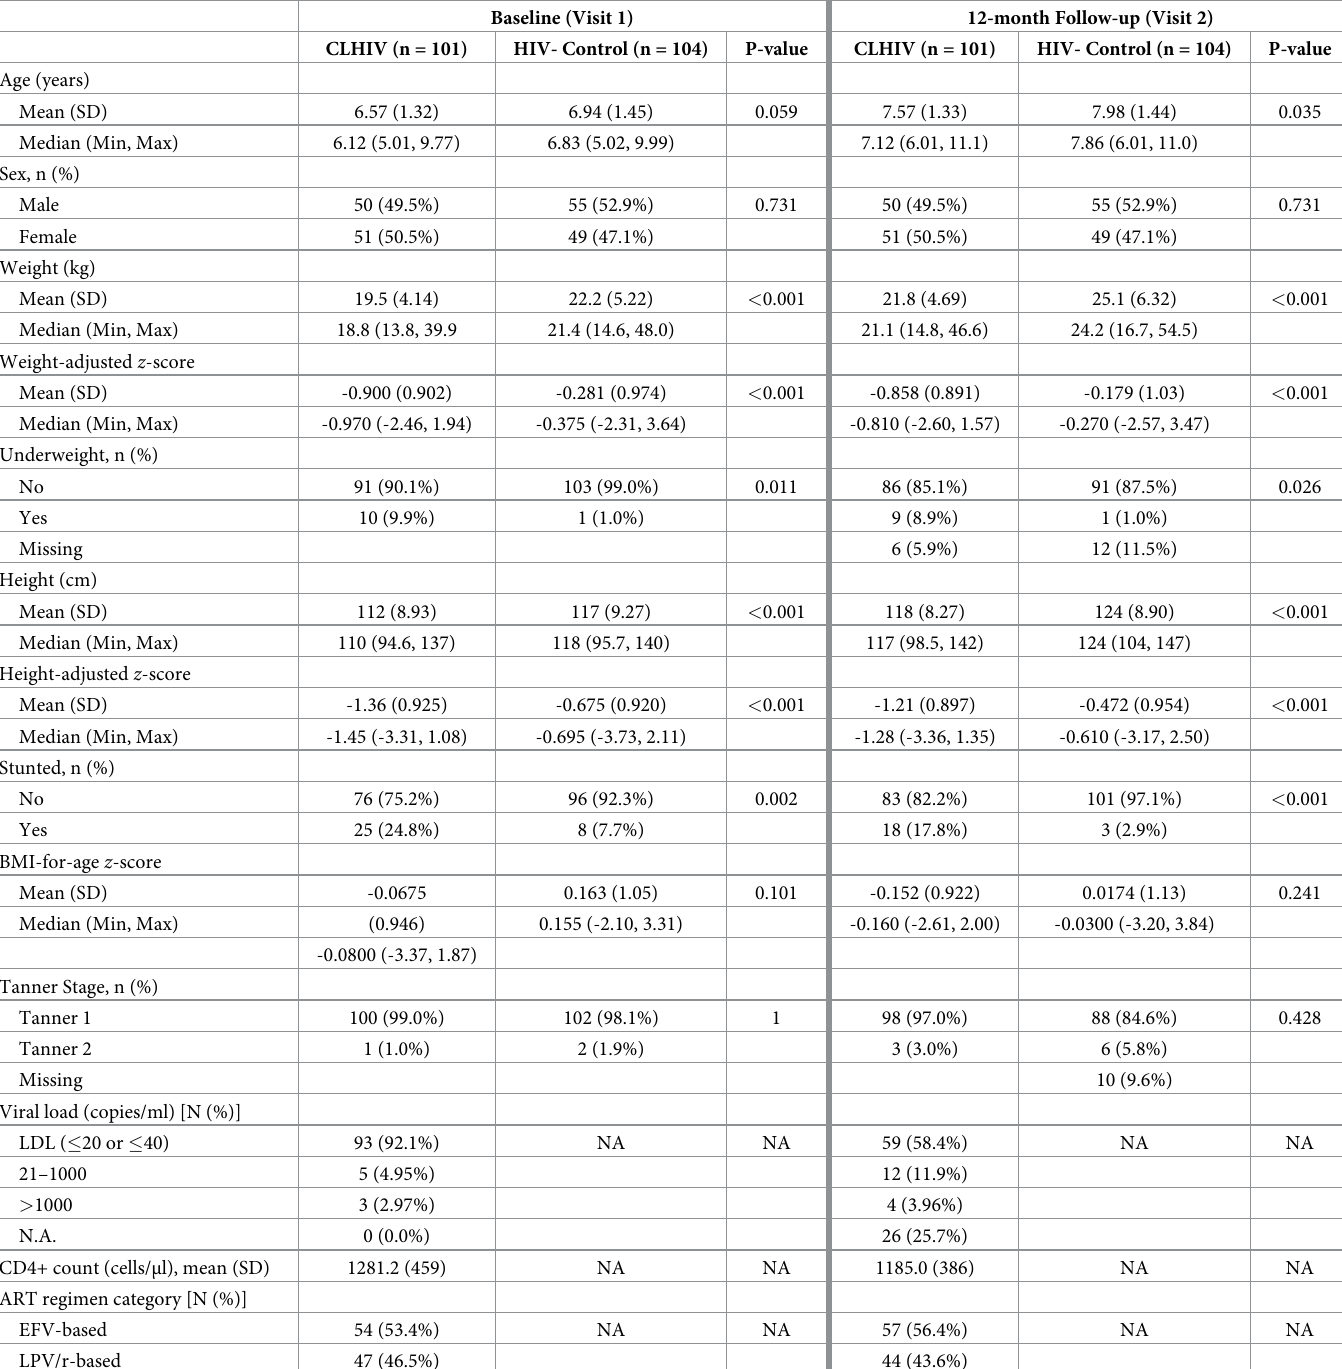
Table 2. Demographic characteristics of participants with Mini-Omnisense QUS